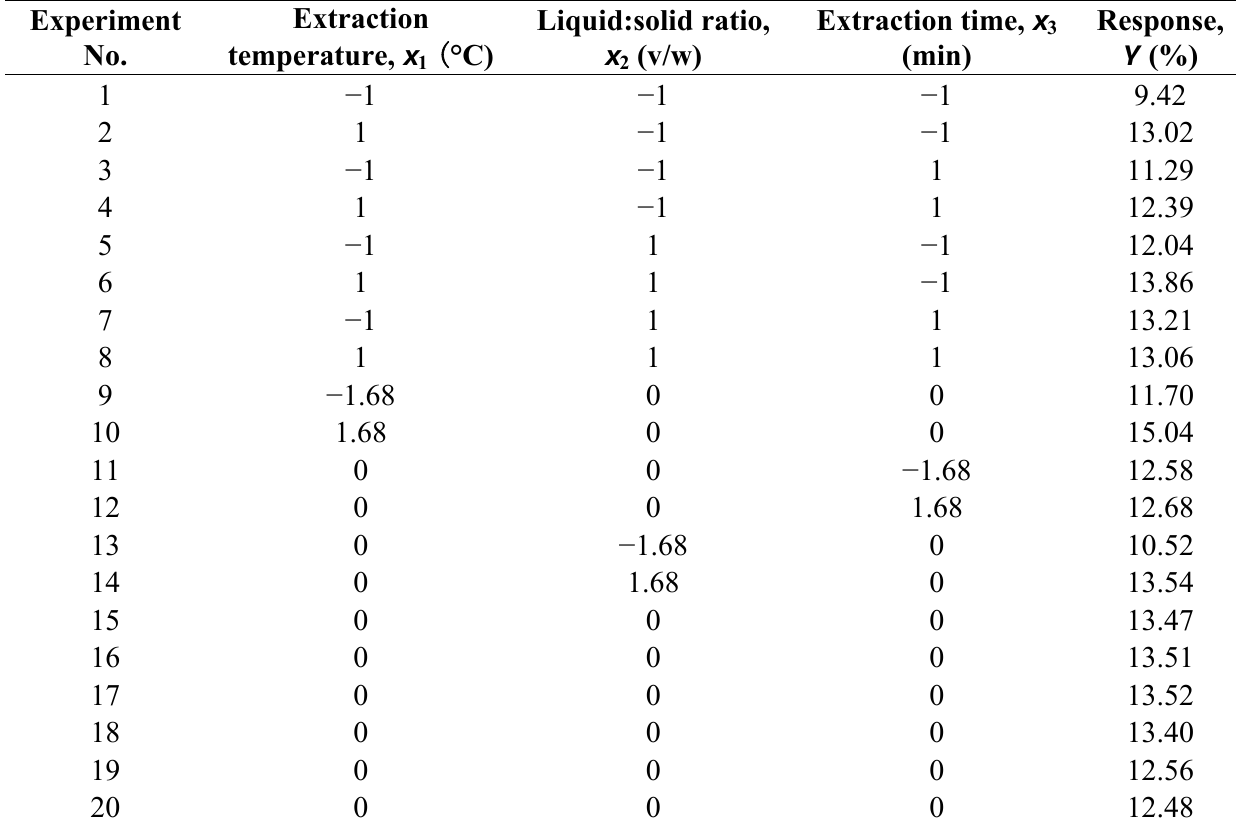
Table 1. The experimental design for response surface analysis in terms of coded values and the experimental